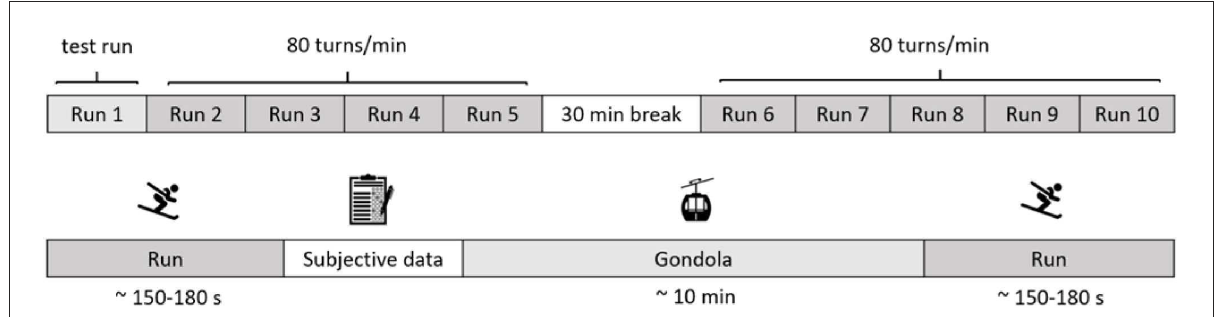
FIGURE1 Design and procedure of the alpine skiing study. The first line provides an overall view of the procedure. The second line presents the procedure of within one run to the following run.